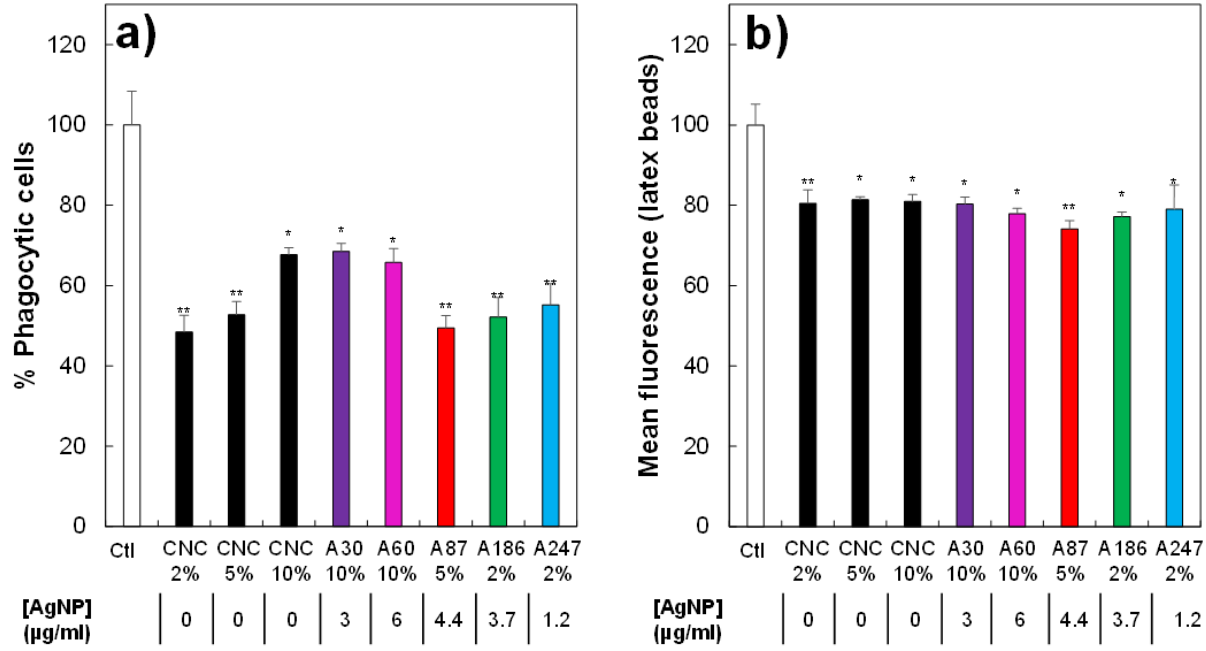
Figure 6. Effects of biocides on the phagocytic capacity of J774A1. ( a ) Proportion of phagocytic cells (in the viable cell population only) for control cells or cells treated for 24 h with different biocide concentrations; ( b ) mean fluorescence of phagocytic cells (in the viable cell population only) for control cells or cells treated for 24 h with different concentrations of biocides. Selected biocide concentration = before reaching lethal dose 20. Symbols indicate the statistical significance (Student’s t -test): * p < 0.05; ** p < 0.01.